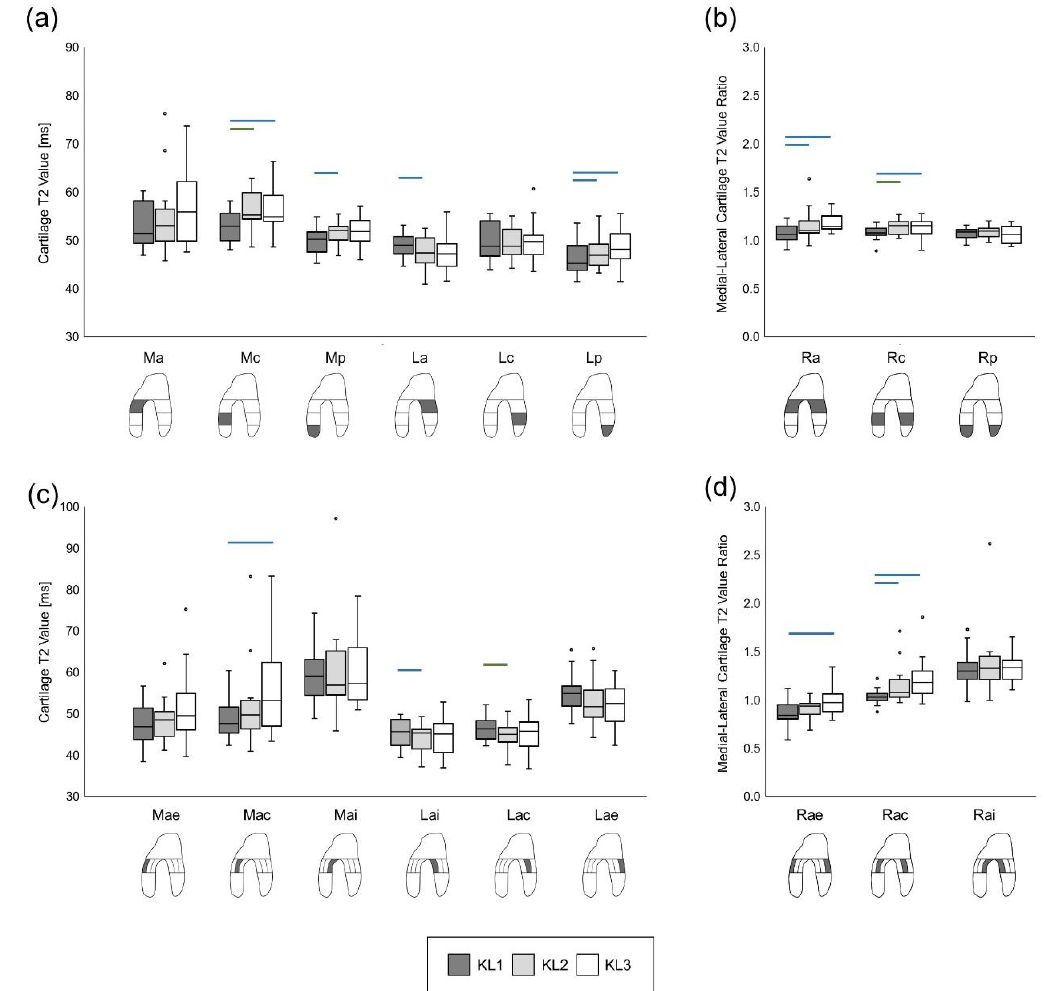
Figure 3. Box and whisker plots of cartilage T2 values per VOI ( a ) and sub-VOI ( c ) and their respective medial-lateral ratios ( b , d ). Horizontal bars indicate statistically significant ( p < 0.017) changes between severity timepoints (blue: ES > 0.5; green: ES > 0.8).